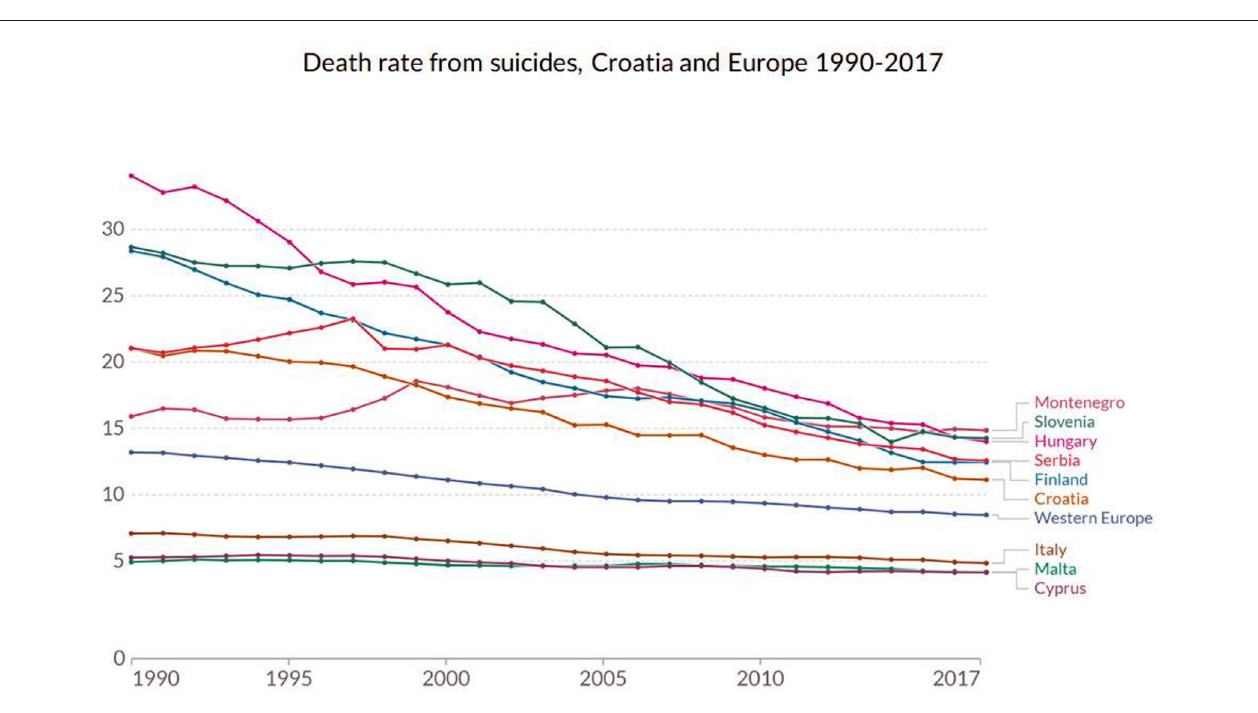
FIGURE 3 | Death rate from suicides, Croatia, with neighboring (Hungary, Slovenia, Serbia and Montenegro), selected Mediterranean countries (Italy, Malta, Cyprus), Finland (pointing toward the Ugro-Finnic suicide hypothesis), and the Western Europe, 1990–2017 (Croatia, 2021). Source: IHME, Global Burden of Disease (GBD).